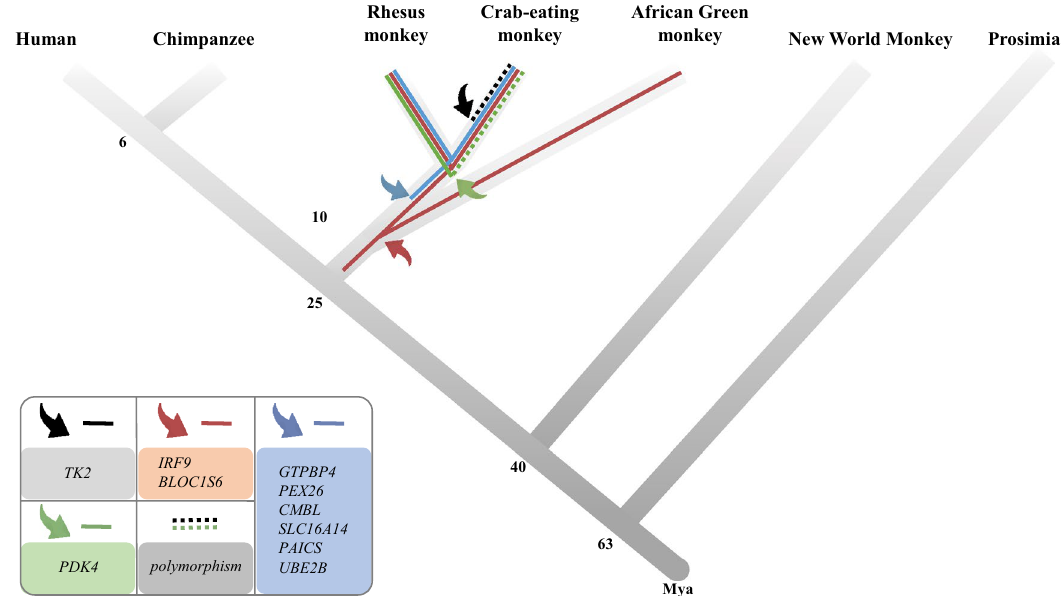
Figure 3. Schematic representation of the integration of Alu YRa1 in 10 genes during primate evolution. Bent arrows and dotted lines represent the integration of Alu YRa1s and polymorphism of Alu YRa1 insertion, respectively. Each color indicates the group of genes that contain associated Alu YRa1. Mya: millions of years